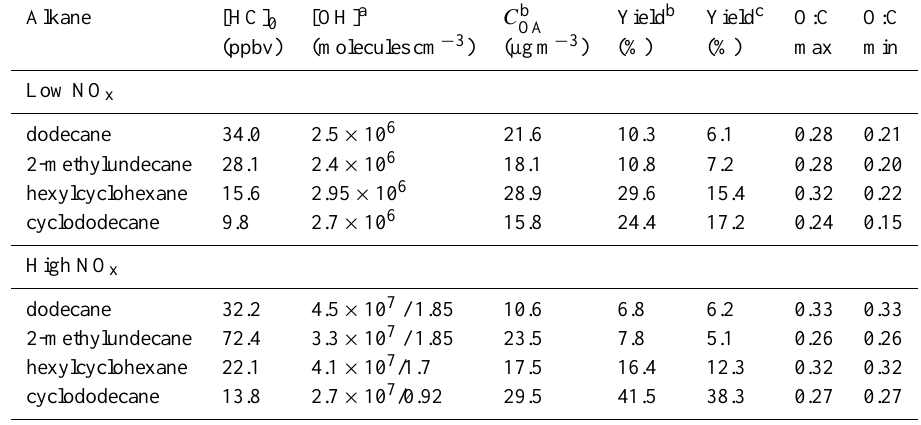
Table 1. Experimental conditions and results from photooxidation experiments. Alkane [HC] 0 [OH] a C b Yield b Yield c O:C O:C OA (ppbv) (moleculescm − 3 ) (µgm − 3 ) (%) (%) max min Low NO x dodecane